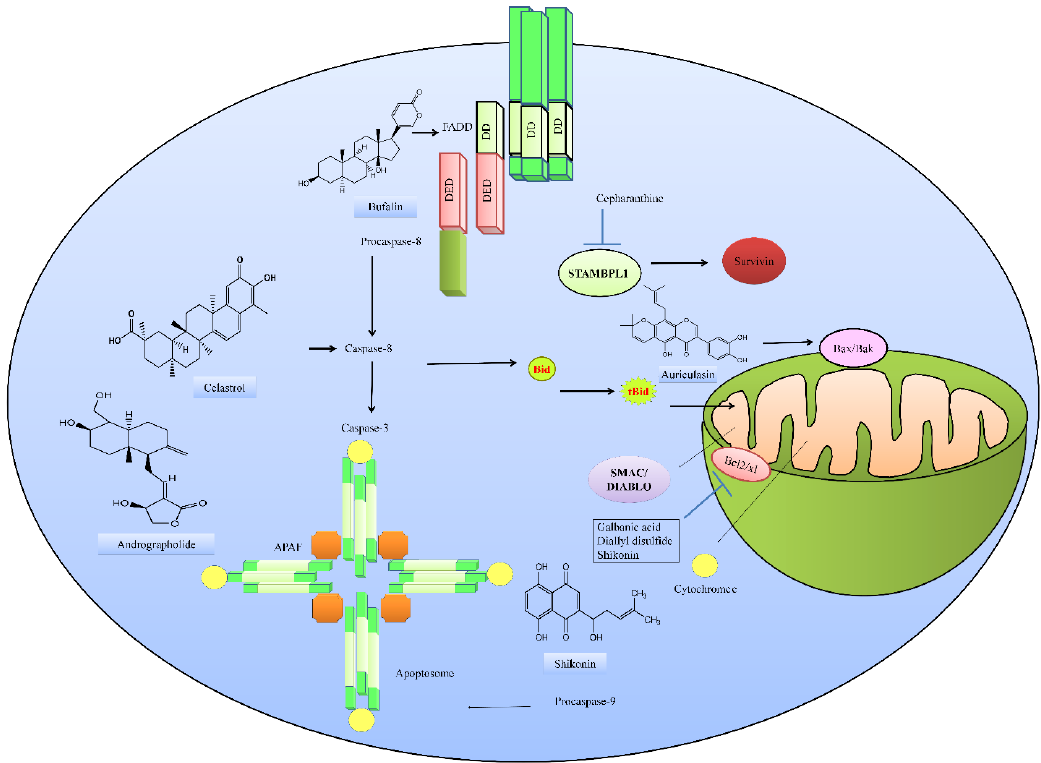
Figure 3. Natural-product-mediated multi-step regulation of the TRAIL-driven pathway.